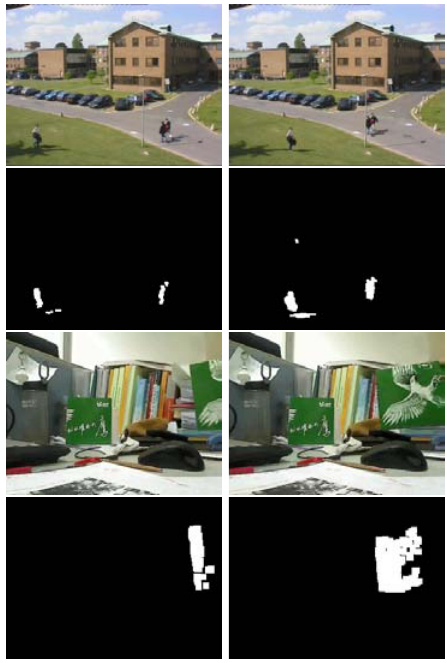
Fig. 4. Objects detection under the fixed angle of